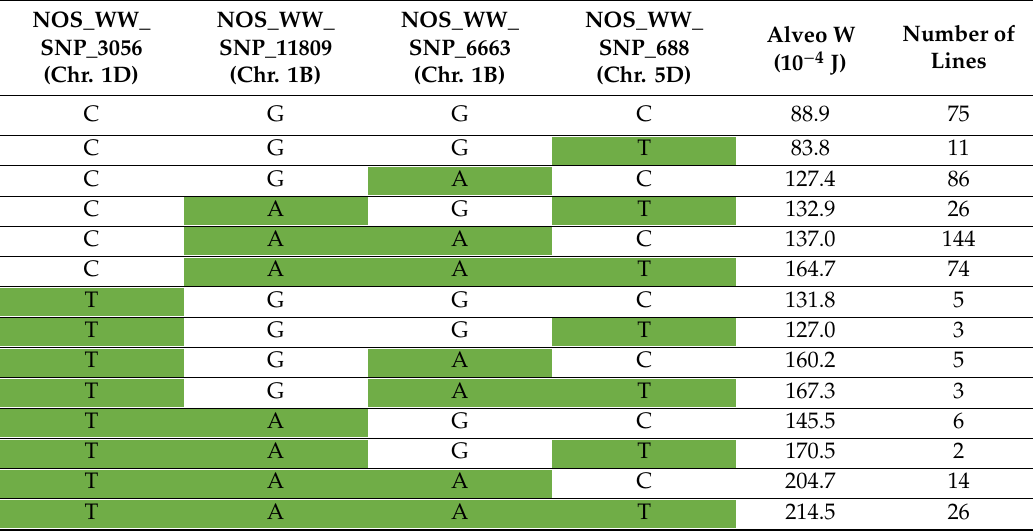
Table 5. Mean values of Alveo W for lines with each combination of alleles of the significant SNPs. Alleles that are positively associated with the trait are marked with